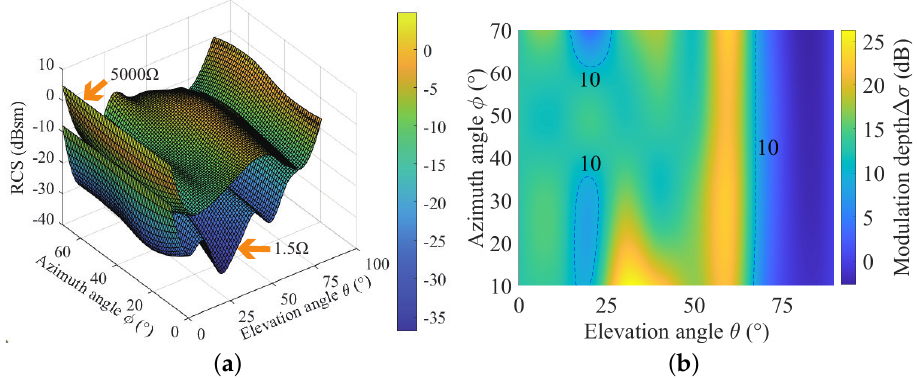
Figure 5. The RCS pattern and modulation depth at 11 GHz. ( a ) The RCS pattern. ( b ) RCS modula- tion depth.